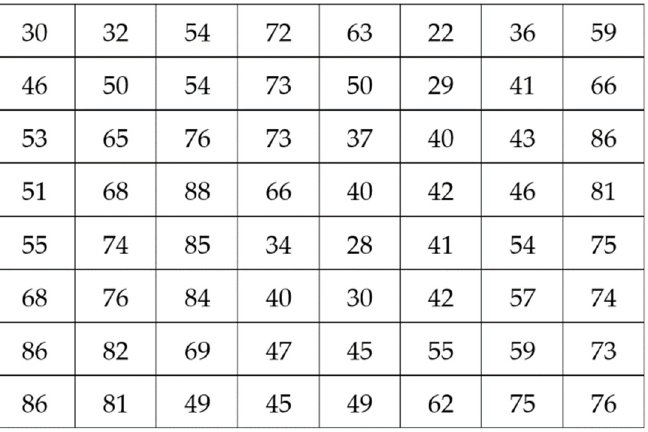
Figure 2. Obtaining a JPEG compressed image.